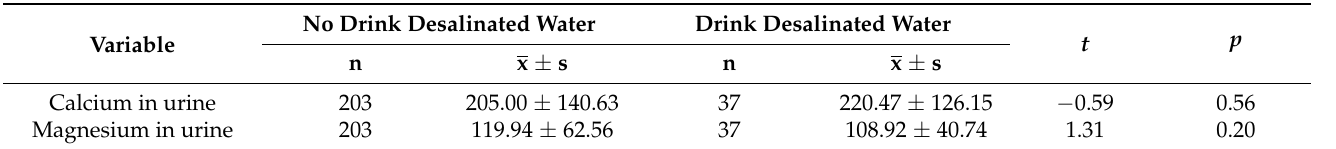
Table 4. Urinary calcium and magnesium levels in different desalinated seawater intake groups (mg/g creatinine).